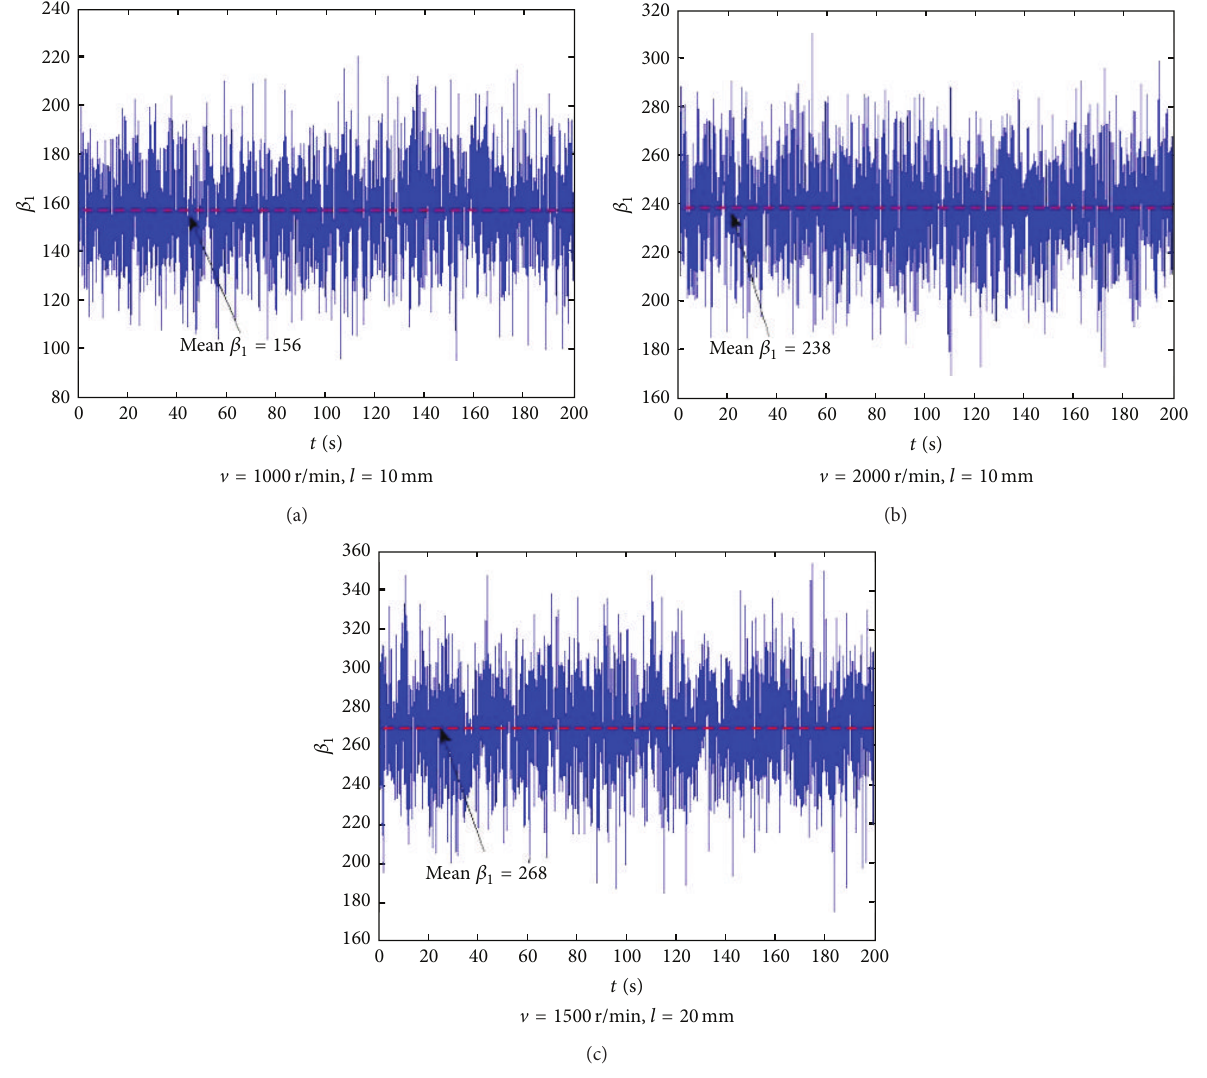
Figure 6: Evolution curves of 1-dimensional Betti